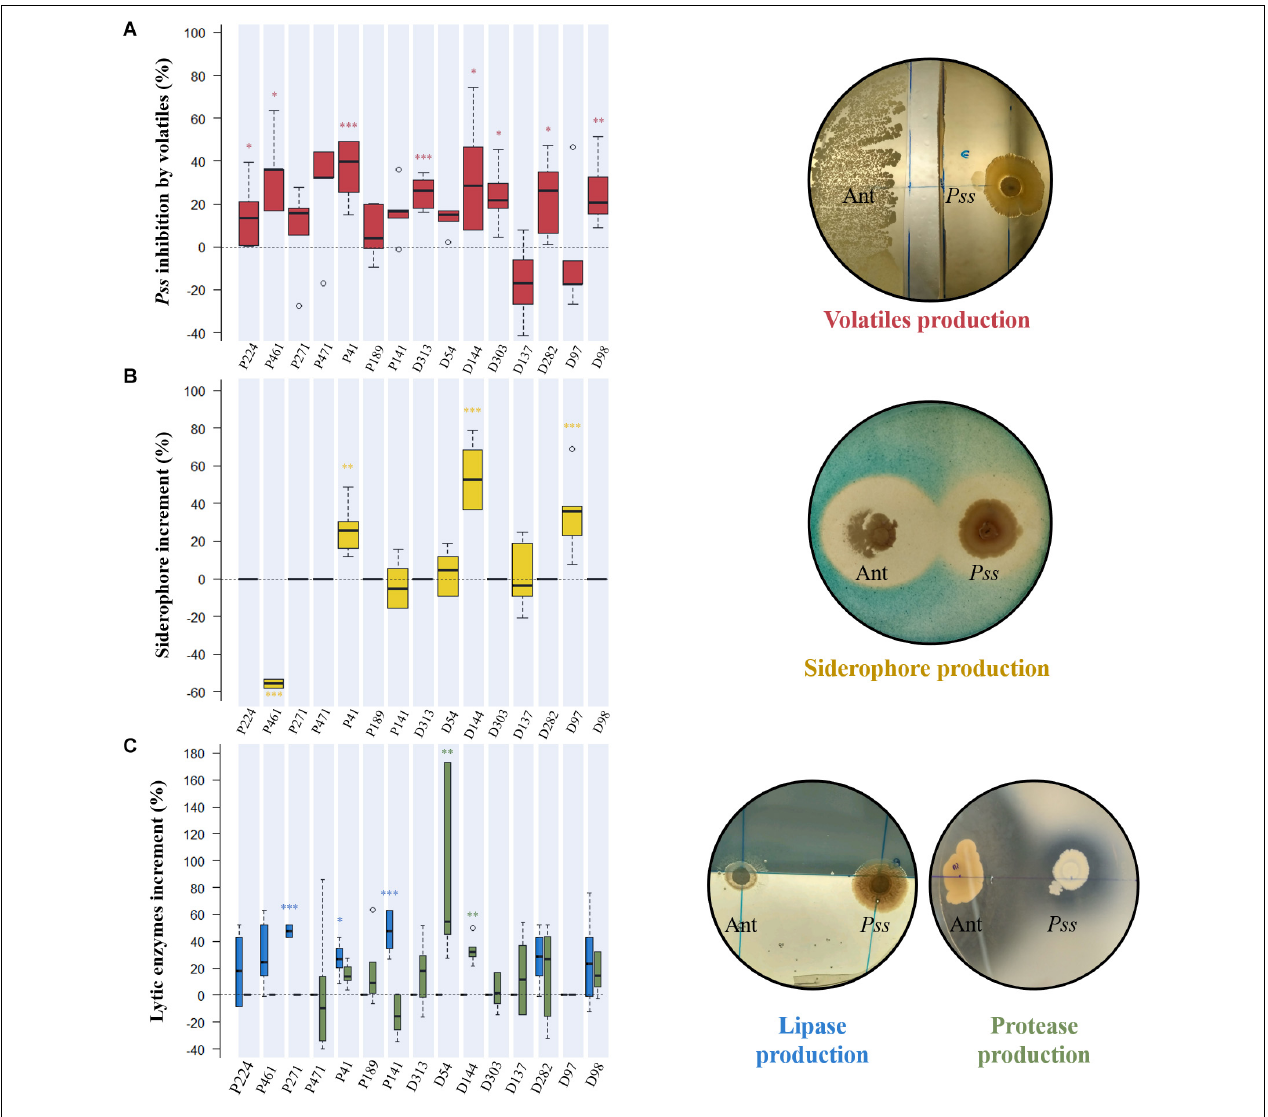
FIGURE 3 | Evaluation of the inhibition mechanism displayed by each antagonistic isolate against Pseudomonas savastanoi pv. savastanoi ( Pss ). The production of antibacterial volatile compounds by antagonists was assessed by estimating their inhibitory effect on Pss growth (%) in dual-culture assays (A) , while the production of siderophores (B) and lytic enzymes (lipase-blue, and protease-green) (C) were evaluated by their increase in dual-culture assays when compared to single inoculated controls. Significant differences from controls are indicated by asterisks (* p < 0.05; ** p < 0.01; *** p < 0.001). Representative plates of different dual-cultures assays with antagonist (Ant) and pathogen ( Pss ) are